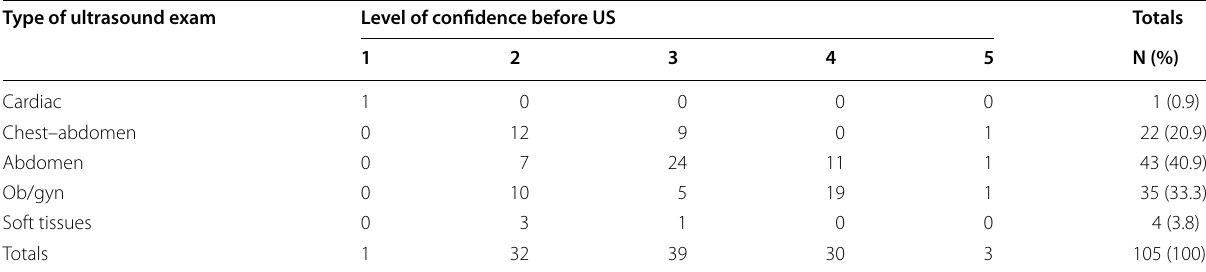
Table 2 Type of ultrasound exam requested according to the relative level of confidence of the attending physician Type of ultrasound